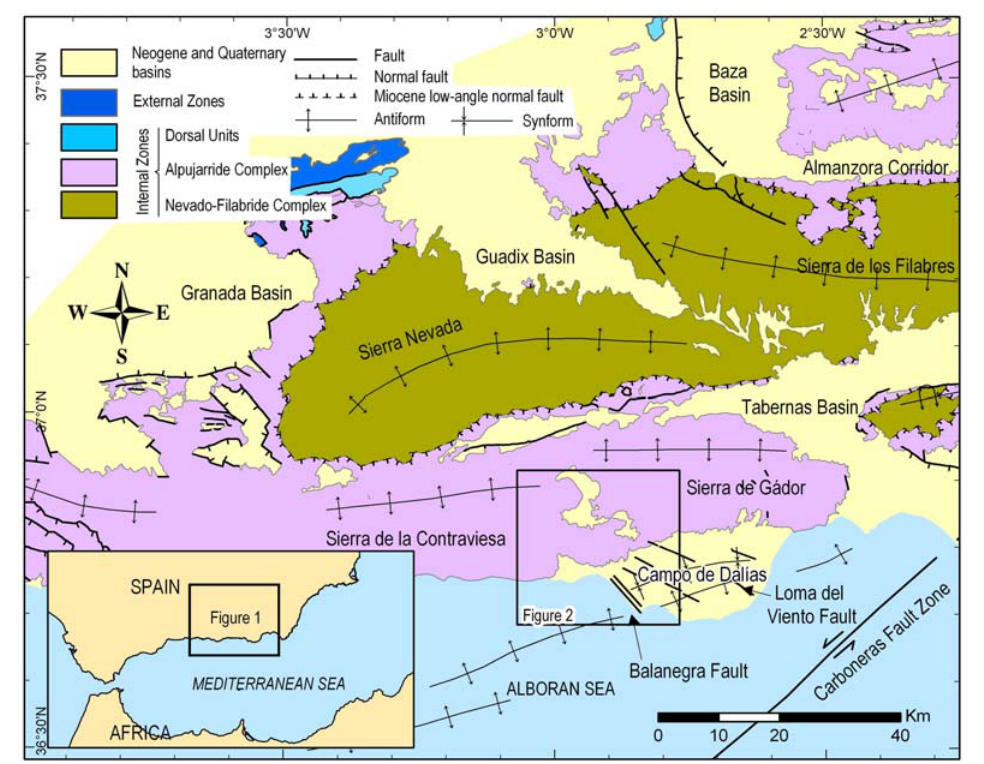
Figure 1. Geological map of the southeastern Betic